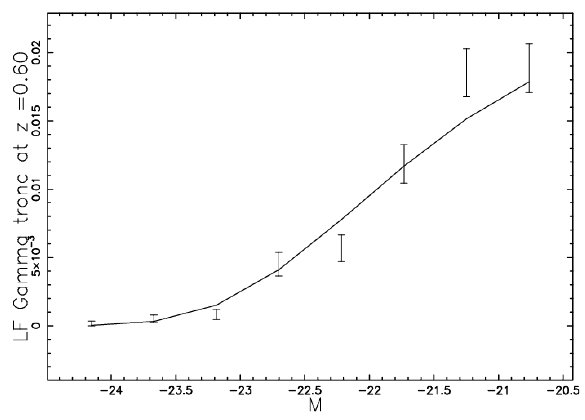
Figure 11. The luminosity function data of zCOSMOS are represented with error bars. The continuous line fit represents our gamma truncated LF (44); the chosen redshift is z in Tables 3 and